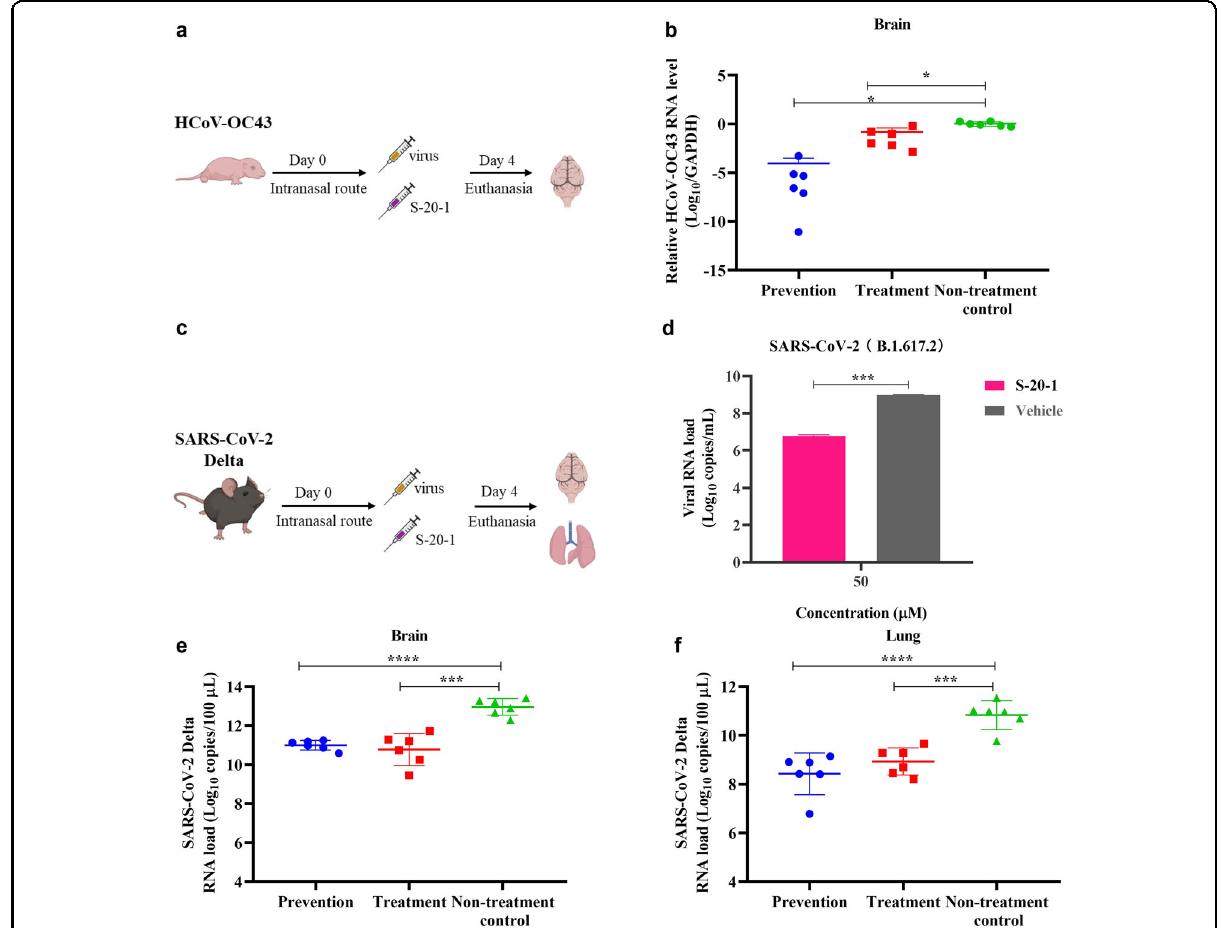
Fig. 5 Prevention and treatment effect of S-20-1 against mouse infection by HCoV-OC43 and SARS-CoV-2 Delta variant. a Schematic diagram of S-20-1 administration and HCoV-OC43 challenge. b In vivo ef fi cacy of S-20-1 (80 mg/kg) against HCoV-OC43 infection in newborn mice. Viral RNA expression level in brain tissue of mice in each group on the 4th day post-infection was detected. c Schematic diagram of S-20-1 administration and SARS-CoV-2 challenge. d Viral RNA expression level after incubation of S-20-1 with authentic SARS-CoV-2 Delta on Caco-2 cells. e , f In vivo ef fi cacy of S-20-1 (60 mg/kg) against SARS-CoV-2 Delta variant infection in hACE2-transgenic C57BL/6 mice. Viral RNA expression level in mouse brain ( e ) and lung ( f ) of each group on the 4th day post-infection was detected. These data were analyzed by Student ’ s t -test ( d ) and One- way ANOVA ( b , e , f